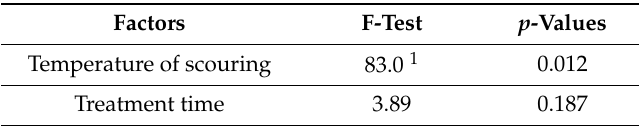
Figure 7. Dye removal vs contact time of rice husk treated with 20 g/L NaOH at 50, 70 and 90 °C for 30 and 60 min (adsorption conditions are 0.1 g/L Congo red, 25 °C, 10 g/L rice husk). Table 4. Evaluated Fisher test (F-test) and p -values for temperature of scouring and treatment time for percent of removed Congo red for 120 min.